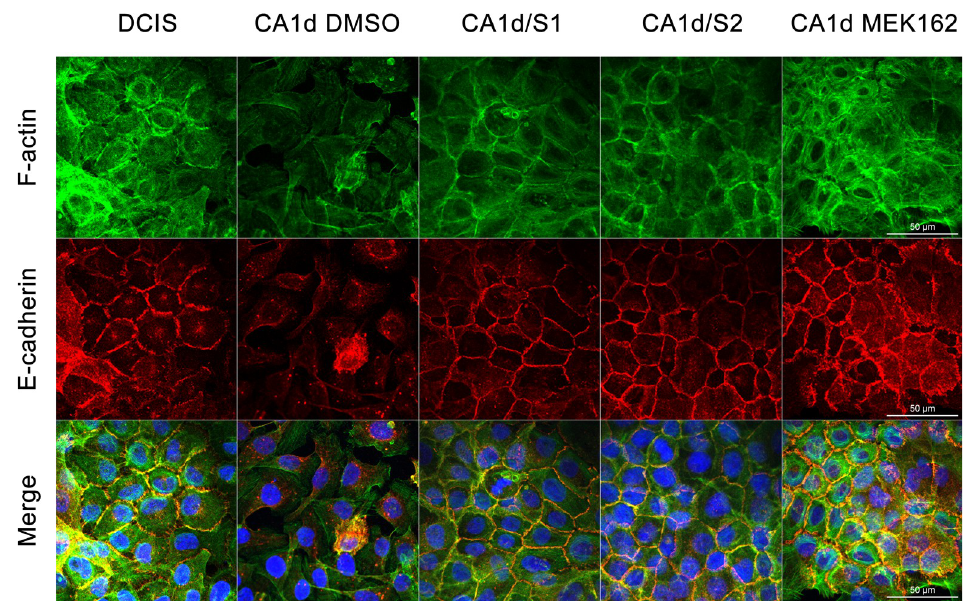
Fig 5. Sprouty4 overexpression promotes an epithelial-like phenotype. MCF10.DCIS, MCF10.CA1d control and Sprouty4 overexpressing cell lines (CA1d/S1 and CA1d/S2) were grown in 2D on glass coverslips for four days. During the last 48 hours CA1d cells were treated with either DMSO or 100 nM MEK162. Confocal fluorescent imaging was performed using a 63x objective. Images show phalloidin-FITC for filamentous actin (green), indirect immunofluorescence for E-cadherin (red), and DAPI for nuclei (blue); size bar = 50 μ m. Sprouty4 overexpression and MEK inhibition lead to the formation of actin cortical ring-like structures, and a change in E-cadherin localization that, together, resemble an epithelial phenotype. Images are representative of three independent